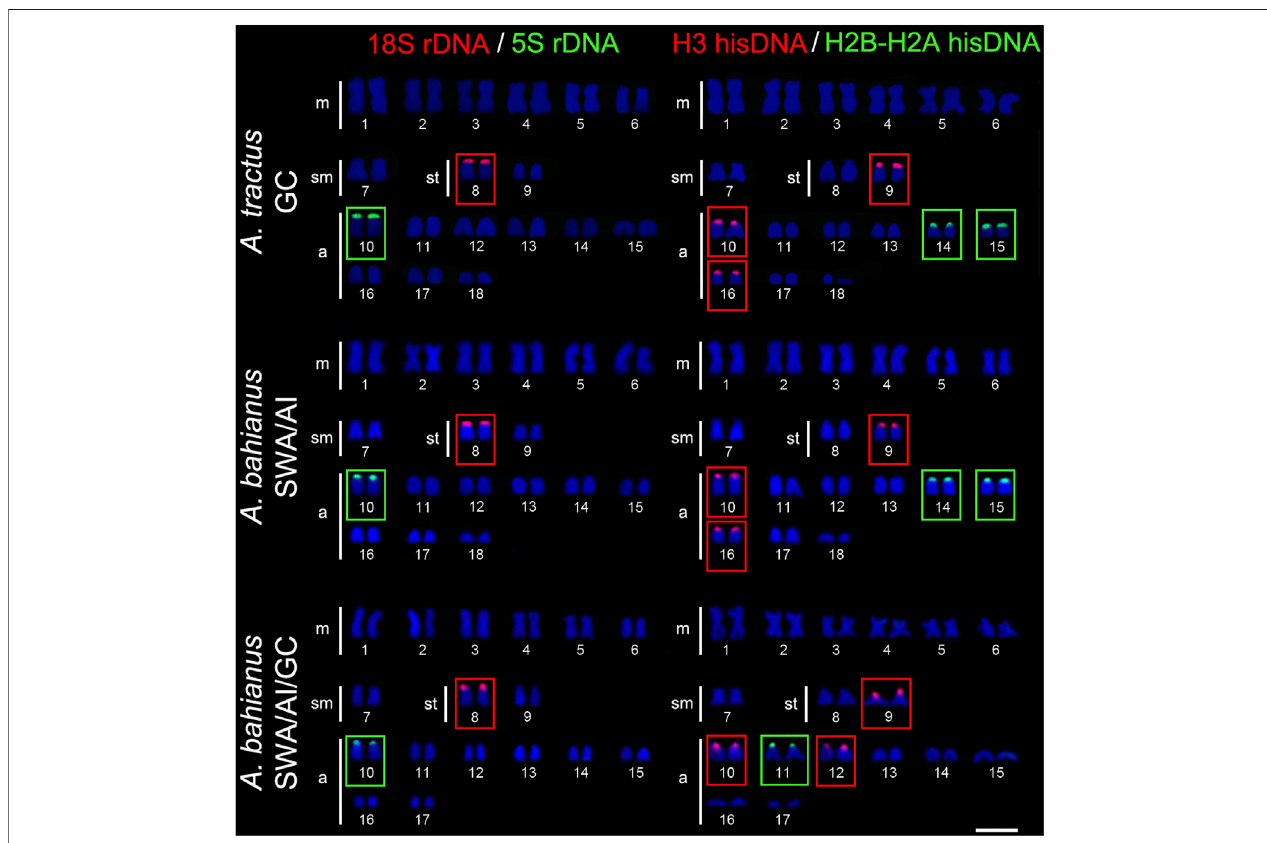
FIGURE 3 | Fluorescence in situ hybridization signals showing the distribution of the 18S rDNA (red signals), 5S rDNA (green signals), H3 hisDNA (red signals) and H2B-H2A hisDNA (green signals) sites in chromosomes of Acanthurus tractus , Acanthurus bahianus , and Acanthurus chirurgus . Scale bar (cid:2) 5 μ m. SWA, Southwest Atlantic; AI, South Atlantic Islands; GC, Greater